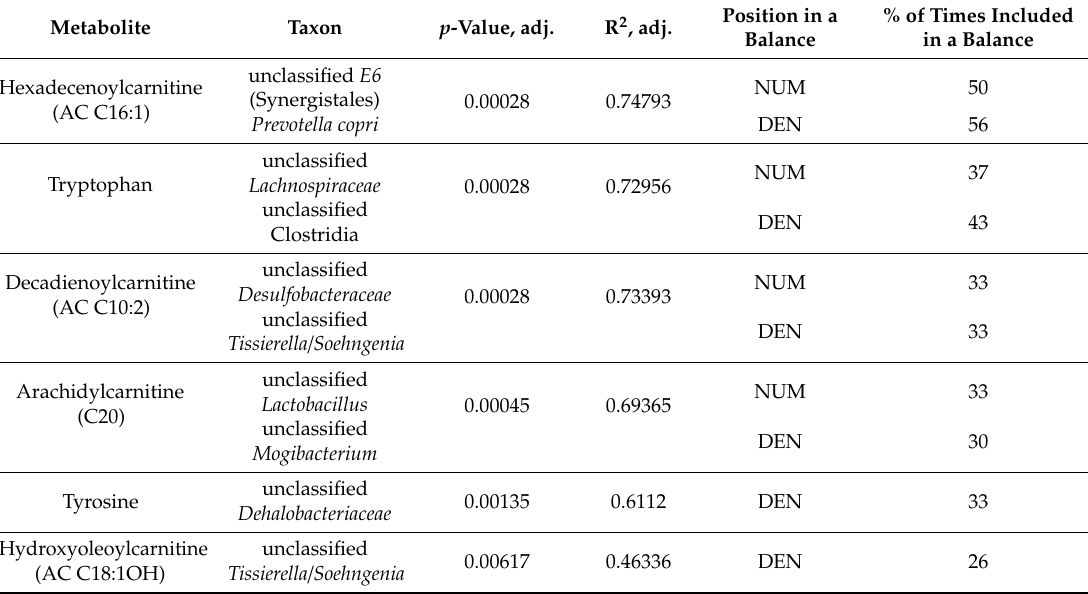
Table 2. Significant associations between blood metabolites and bacterial abundance. NUM—numerator,